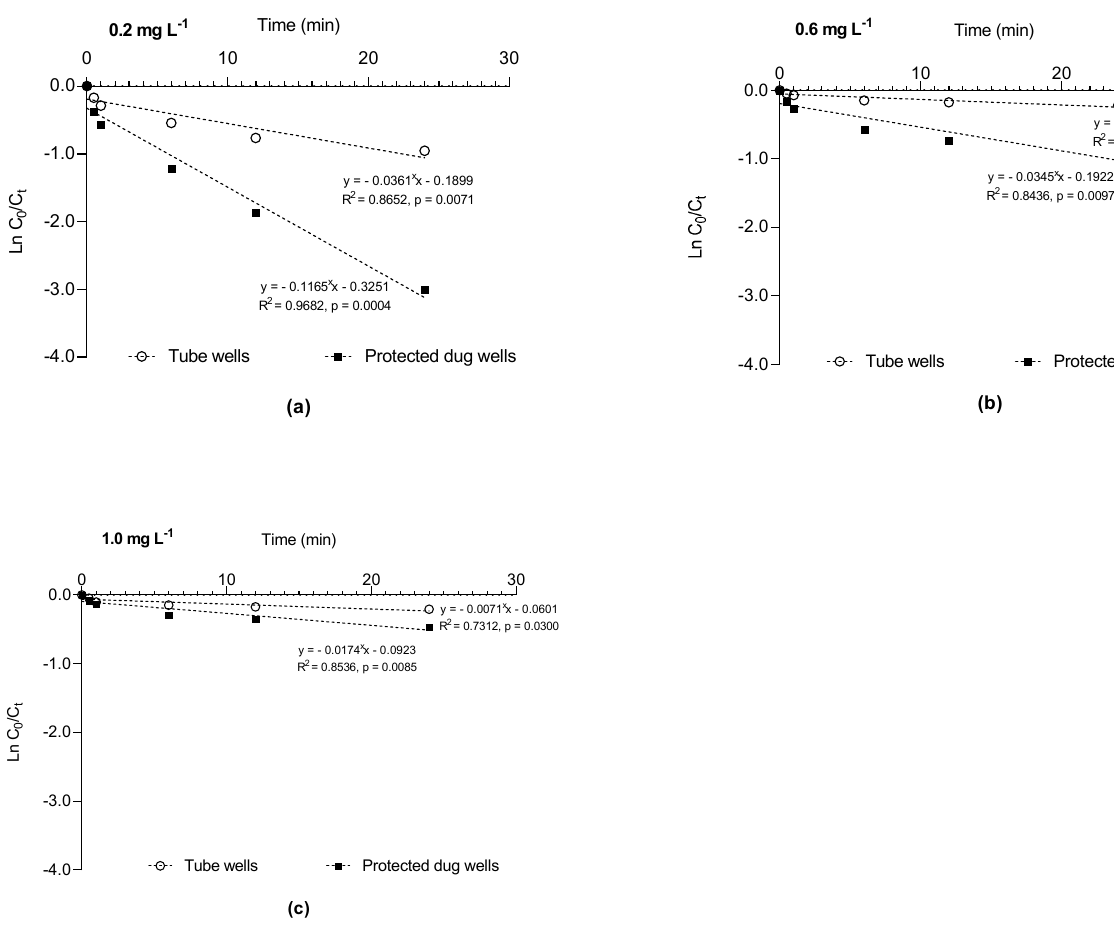
Figure 3. Decay of sodium hypochlorite as a function of time for initial concentrations of 0.2 mg · L − 1 ( a ), 0.6 mg · L − 1 ( b ) and 1.0 mg · L − 1 ( c ).